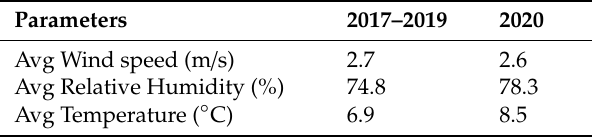
Table 3. Comparison of meteorological